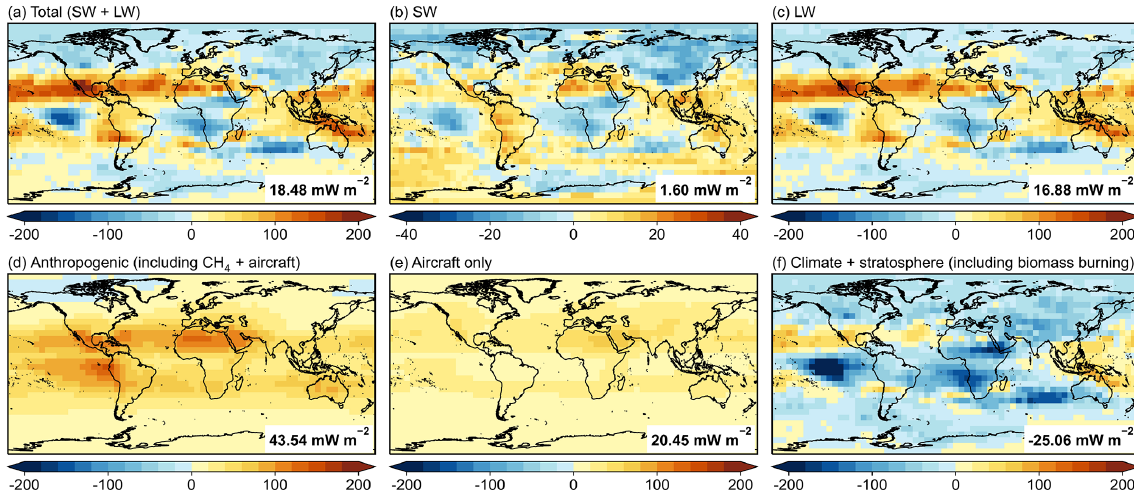
Figure 13. Tropospheric ozone radiative impacts and attributions for 2013–2017 vs. 1995–1999. (a–c) The tropospheric ozone radiative impacts (mWm − 2 ) for total (SW + LW) and for SW and LW, respectively. (d–f) Attribution of the tropospheric ozone radiative impacts due to changes in anthropogenic emissions (including surface emissions, aircraft emission, and global methane levels), aircraft emissions alone, and climate (including the stratosphere and biomass burning) between 2013–2017 and 1995–1999. The values of the annual global mean are shown